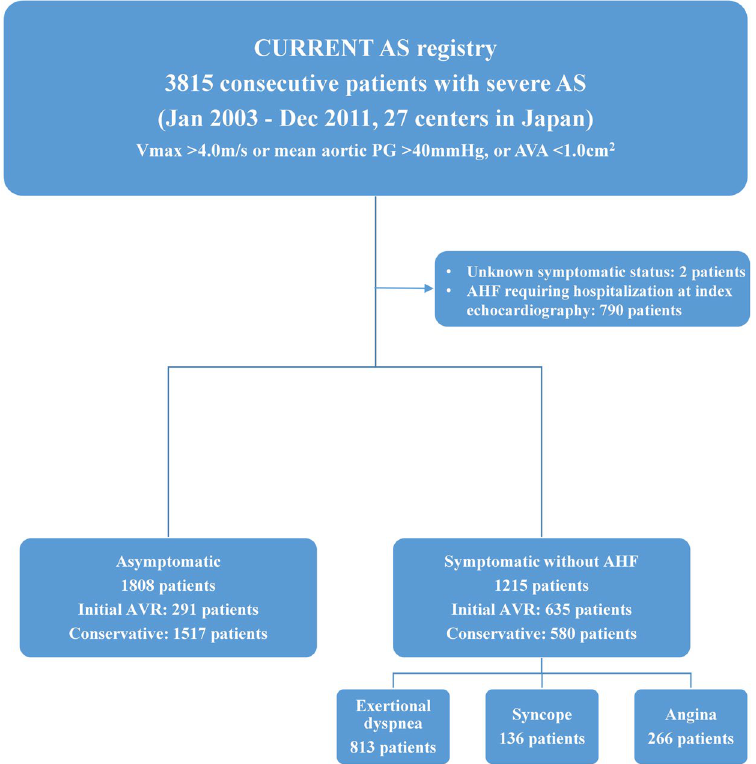
Figure 1. Study patient flow. AS = aortic stenosis; AHF = acute heart failure; AVA = aortic valve area; AVR = aortic valve replacement; PG = pressure gradient; Vmax = peak aortic jet